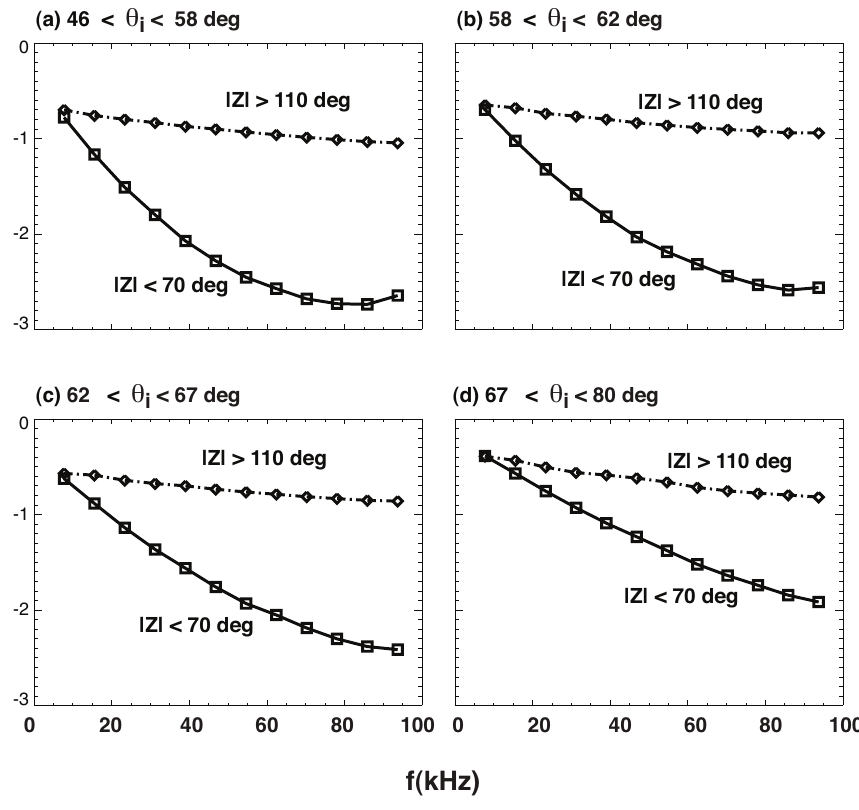
Fig. 9. Average log 10 (reflectivity) versus frequency for four different ranges of ionospheric angle of incidence, from (a) steepest-incidence to (d) most grazing incidence. Dashed curves show the pure-nighttime data, solid curves the pure-daytime data. The discrete symbols are the Fourier frequencies. Each point is the average over all events in the Z and θ i range box. These data have not been detrended against systematic variations with either Z or azimuth. The smooth variation versus frequency is primarily due to our reduction of the frequency information to just a quadratic fit (see Fig. 4 above) in analyzing each event’s reflection. This smooth variation may mask details of the frequency response that cannot be captured by a quadratic